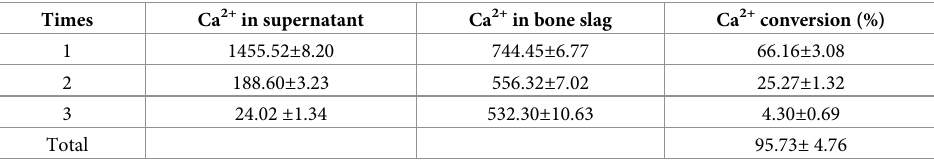
Table 4. Effect of ultrasound cycles on the efficiency of free calcium extraction from bovine bone.